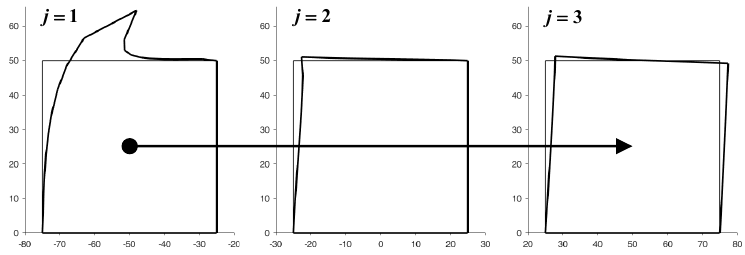
Figure 15. First iteration from left to right: the j -th element generates the forces on the left side of the ( j + 1 ) -th element, with j = 1,2 (Thin line: undeformed configurations. Thick line: deformed configurations. Amplification factor of the displacements: k = 200 ).